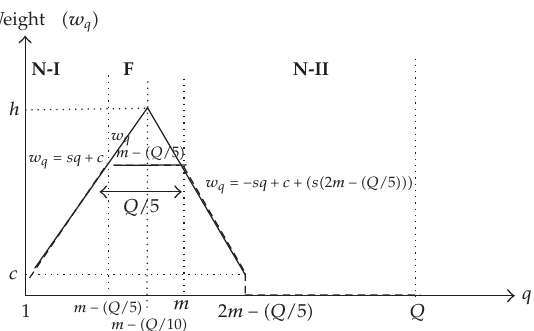
Figure 8: The weighting function of Eigenvector Weighting Function (cid:2) EWF (cid:3) , represented in the dotted